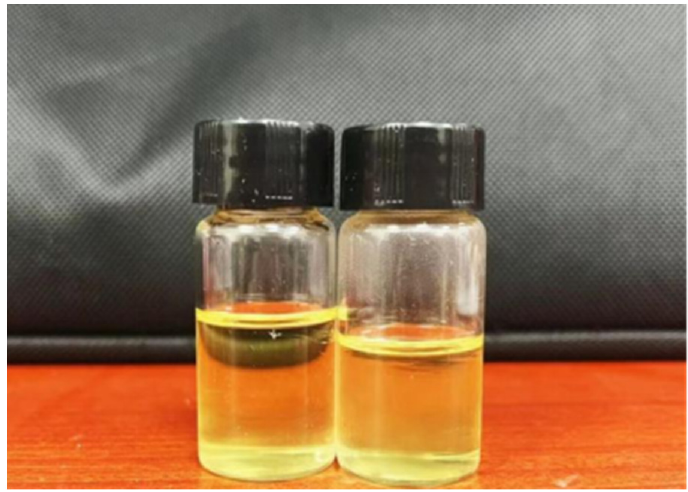
Figure 9. Self ‐ emulsifying non ‐ ionic waterborne epoxy curing agent. Figure 9. Self-emulsifying non-ionic waterborne epoxy curing